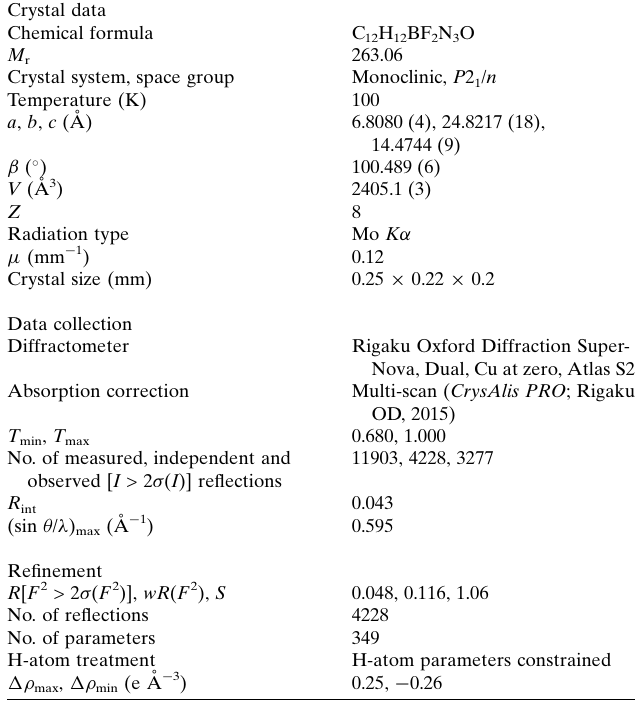
Table 2 Hydrogen-bond geometry (A˚ , (cid:4) ). Cg 2 and Cg 6 are the centroids of the N4/C13–C16 and N1/C1–C4 rings, respectively.